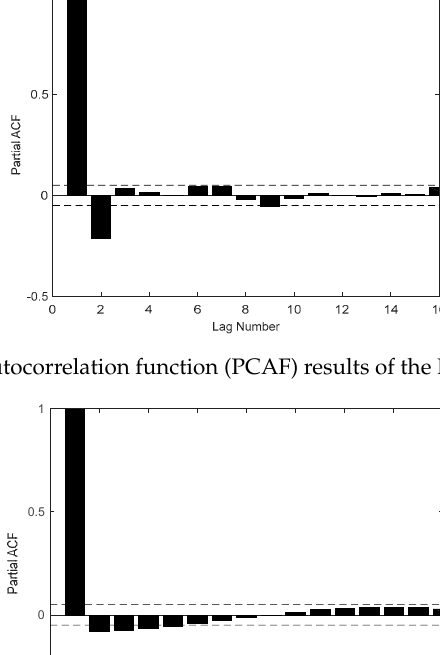
Table 4. The results of external and internal input factors selection for EUA spot price forecasting.